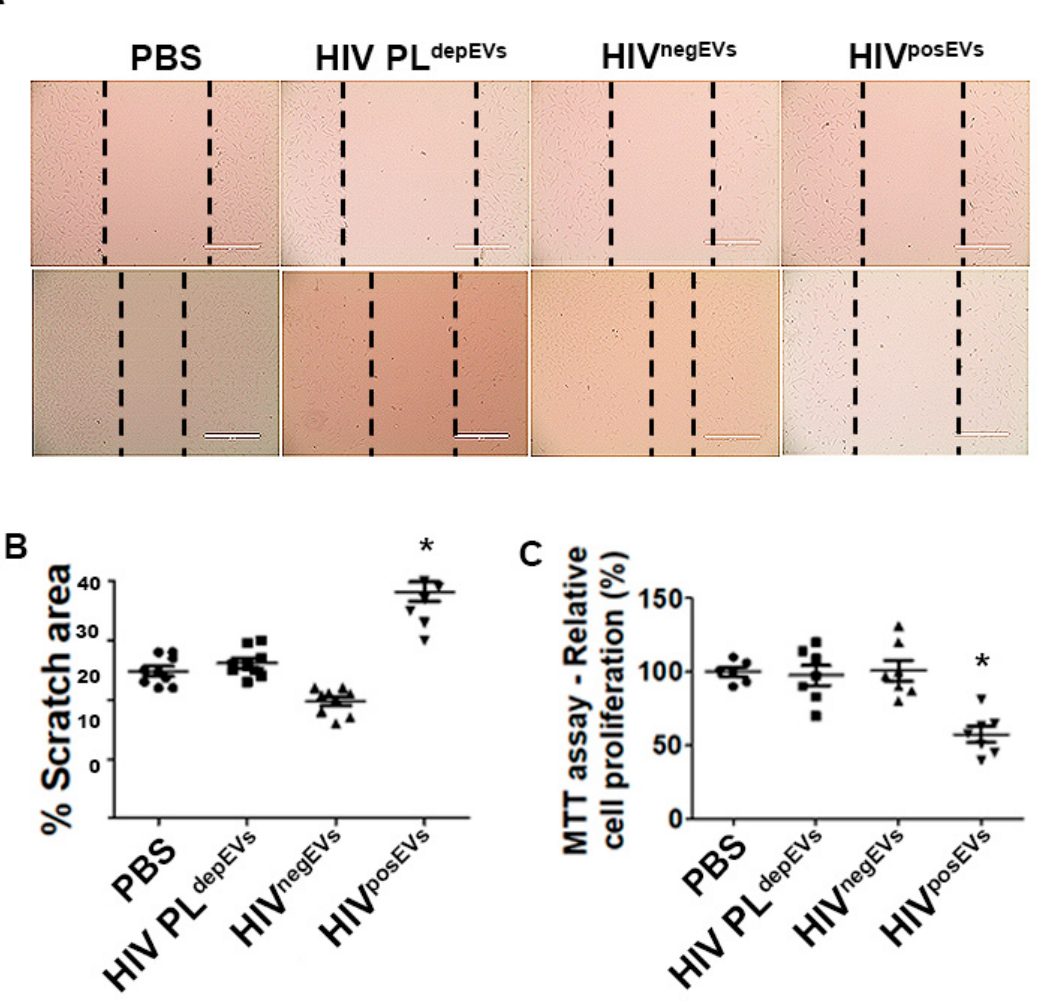
Figure 5. HIV posEVs treatment results in impaired migration and diminish proliferation in ECs in vitro. Mouse aortic ECs isolated from 3-week-old apoE − / − mice exposed to HIV posEVs show slower migration ( A , B ) and lower cell proliferation after 96 h of exposure ( C ), compared with HIV PL depEVs , HIV negEVs and PBS. Dashed lines in panel C mark the edges of the scrach in the cell monolayer . The experiments were performed in triplicate and repeated thrice (* p < 0.05). Statistical tests used: Kruskal–Wallis and Dunn’s Multiple Comparison Test as a post test. Scale bars: 400 µm.